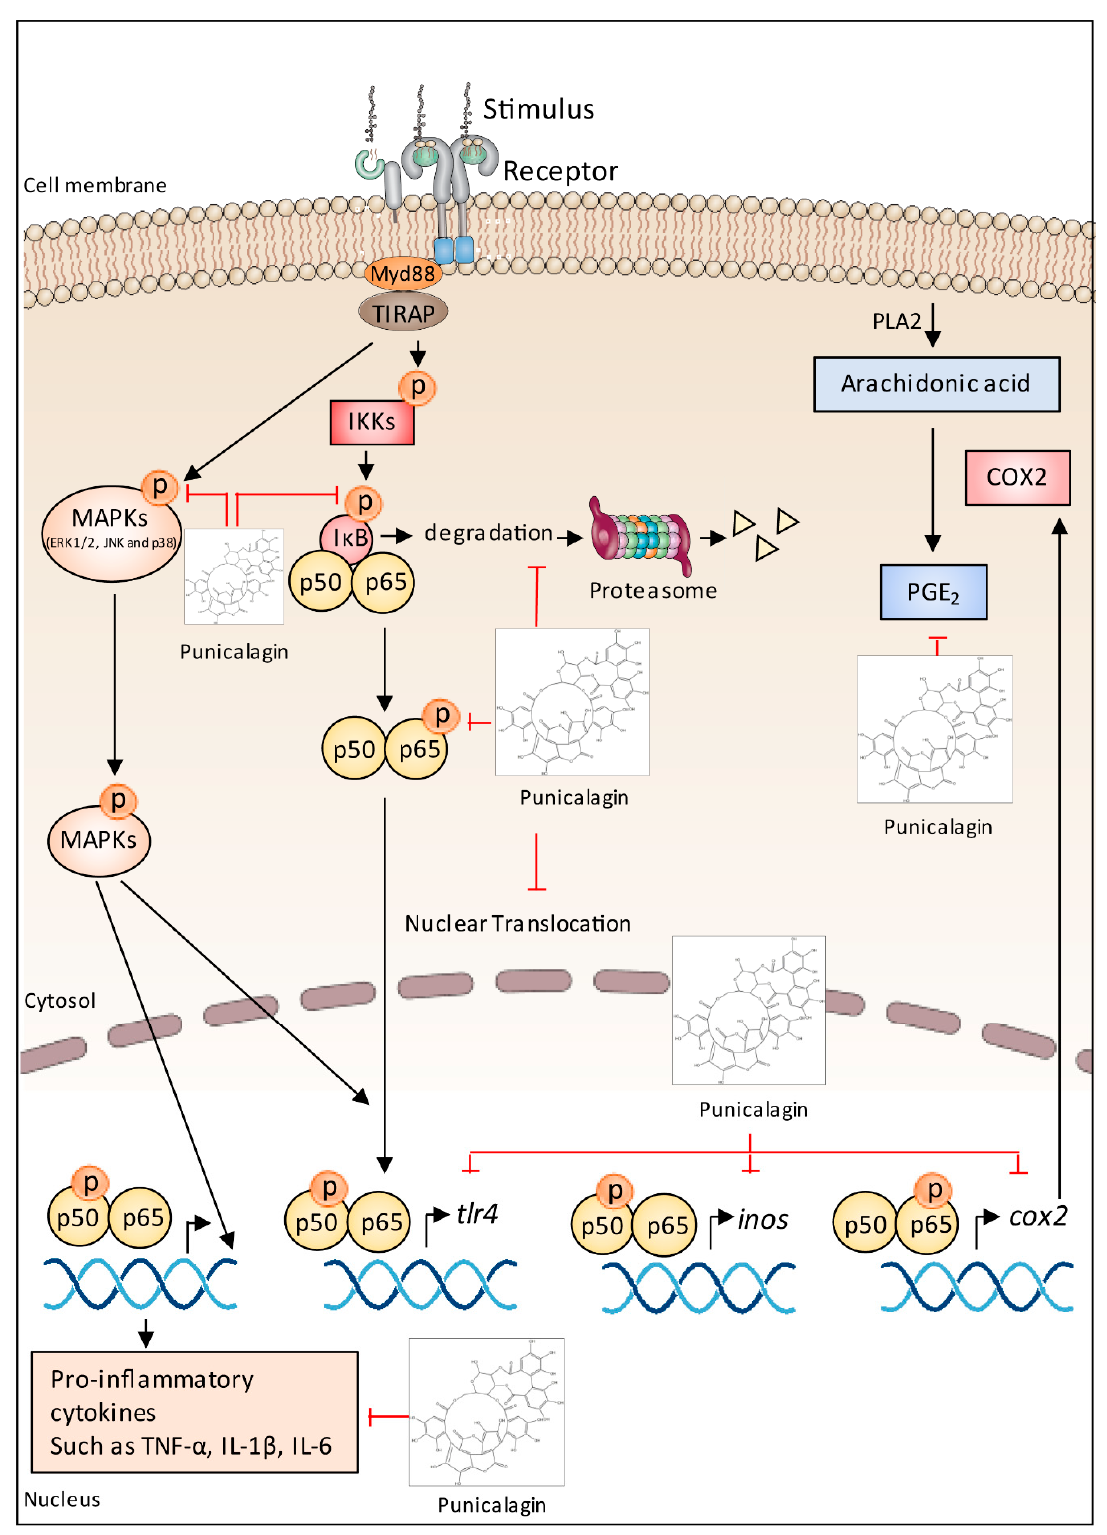
Figure 5. Anti-inflammatory mechanisms of punicalagin. Triangles represent degraded IkB.